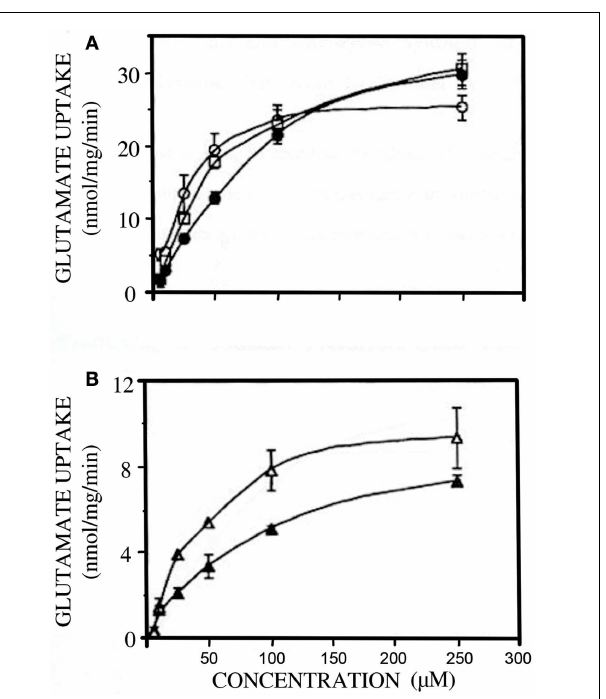
FIGURE 10 | Developmental changes in glutamate uptake in primary cultures of mouse astrocytes (A) and cerebral cortical neurons (B) . (A) open circles, open squares and filled circles: 7, 18 and 30 days in culture; (B) open triangles 4 and closed triangles 8 days in culture. From Peng